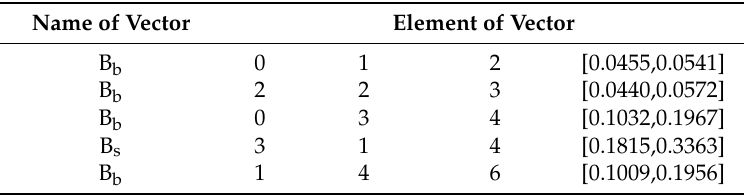
Table 7. Identification template 3 for forest class.